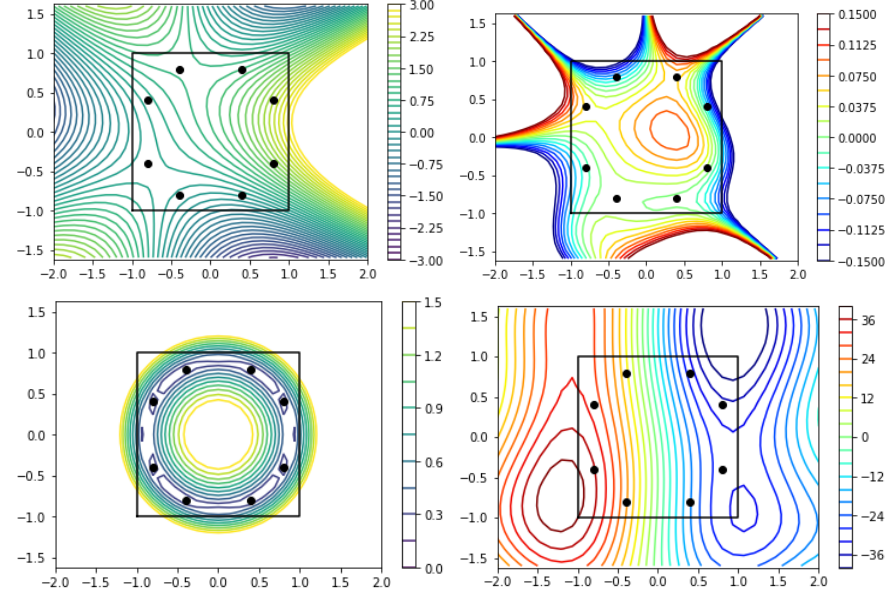
Figure 2. GP reconstruction of case in Figure 1 with generic squared exponential kernel ( top left ) with predicted 95% confidence interval ( bottom left ). Difference to reconstruction with source-free kernel (26) ( top right ) and source density ¯ q = ∆ ¯ u of prediction ( bottom right